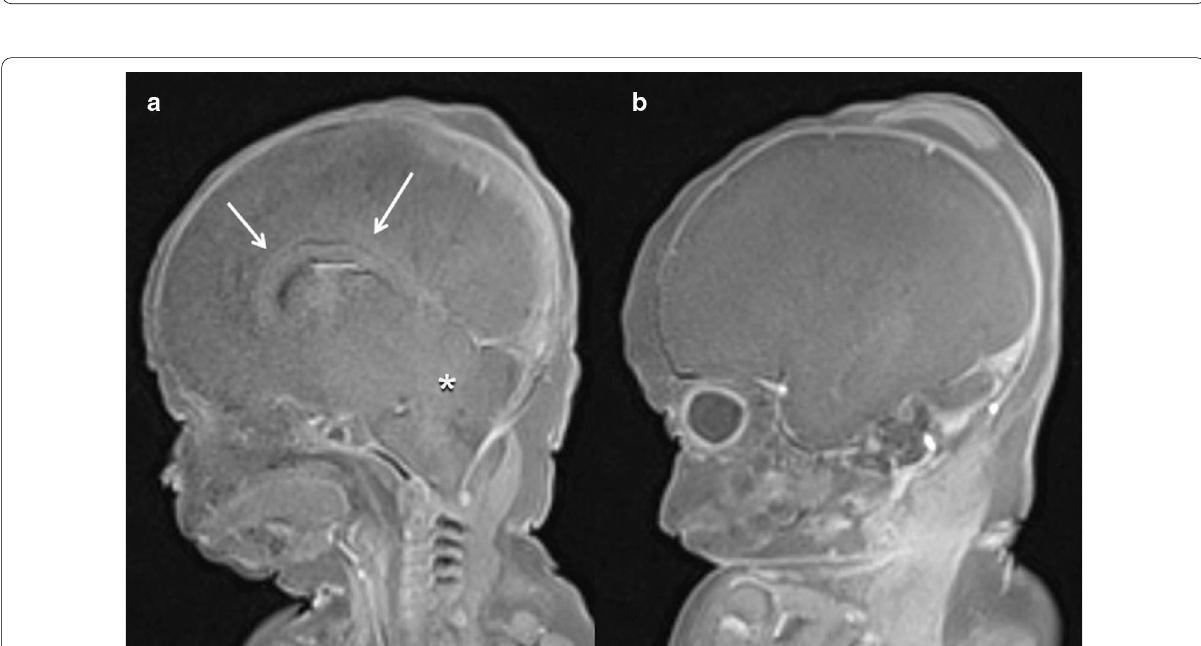
Fig. 3 25‑week foetus with normal cerebral lamination. a , b Sagittal T1‑weighted images, normal midline corpus callosum (arrows) and posterior fossa